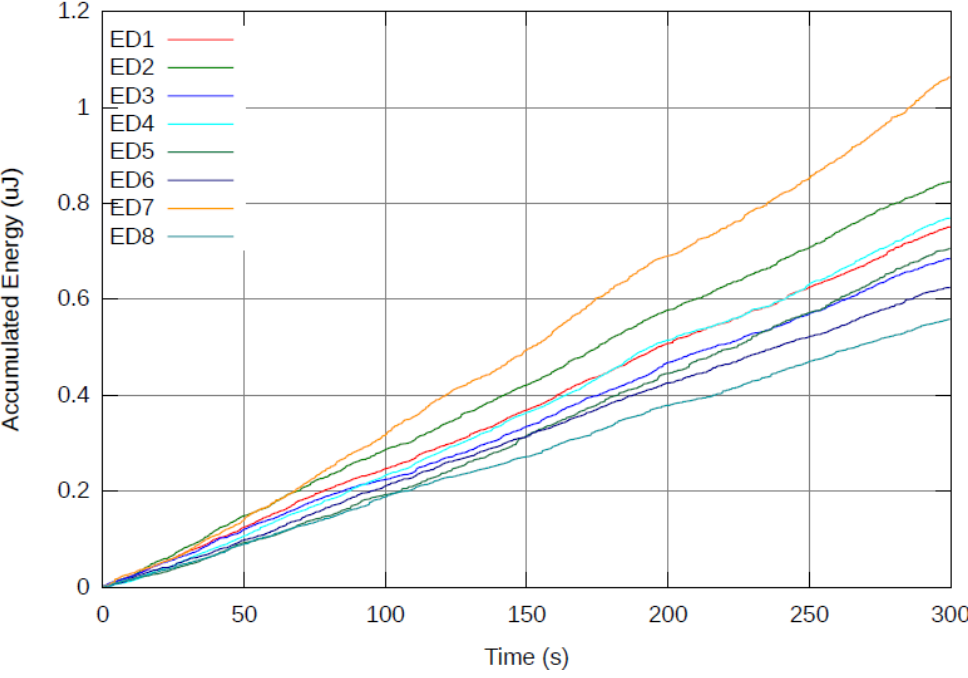
Figure 5. Accumulated energy spent by each end device over time for reference system ( M = 0). Note that ED7 would eventually deplete its battery while energy still remains at other nodes of the network.